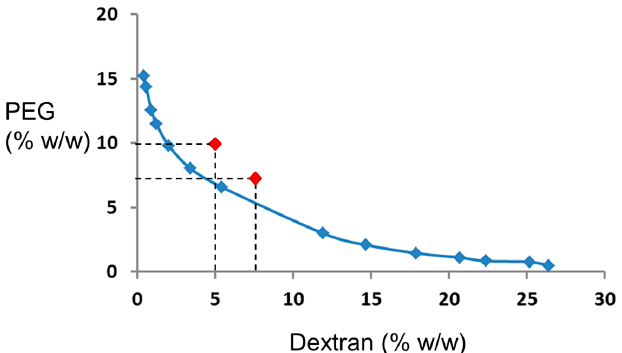
Figure 3. Phase diagram of the dextran (DEX)-polyethylene glycol (PEG) system, assuming that the compositions are approximately the same as those in [3]. The blue dots and the binodal curve are reconstructed from the data of the top and bottom phase table in ref. [3]. The average molecular weight (MW) of their polymers were 6000 (PEG) and 23,000 (DEX), which are similar to those of our system (PEG 8000–DEX 20,000). The red dots indicate the total system compositions that were attempted to investigate the partitioning of surface-modified microbeads in our study.